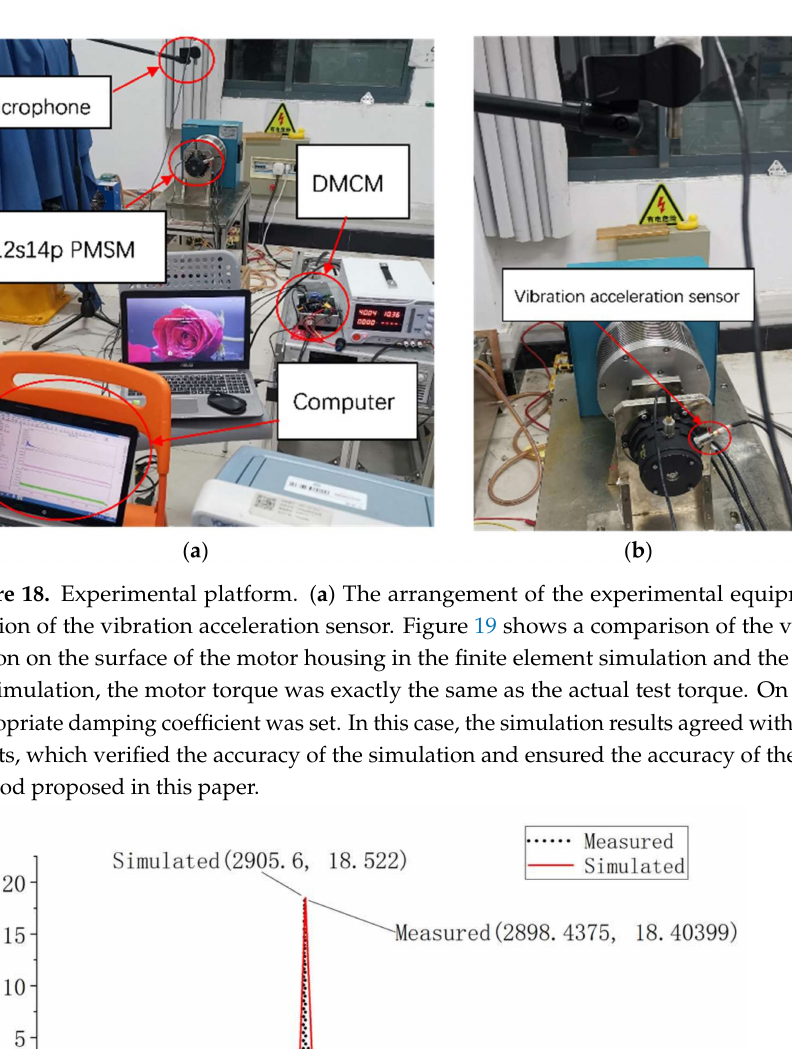
Figure 17. Picture of the PM motor.